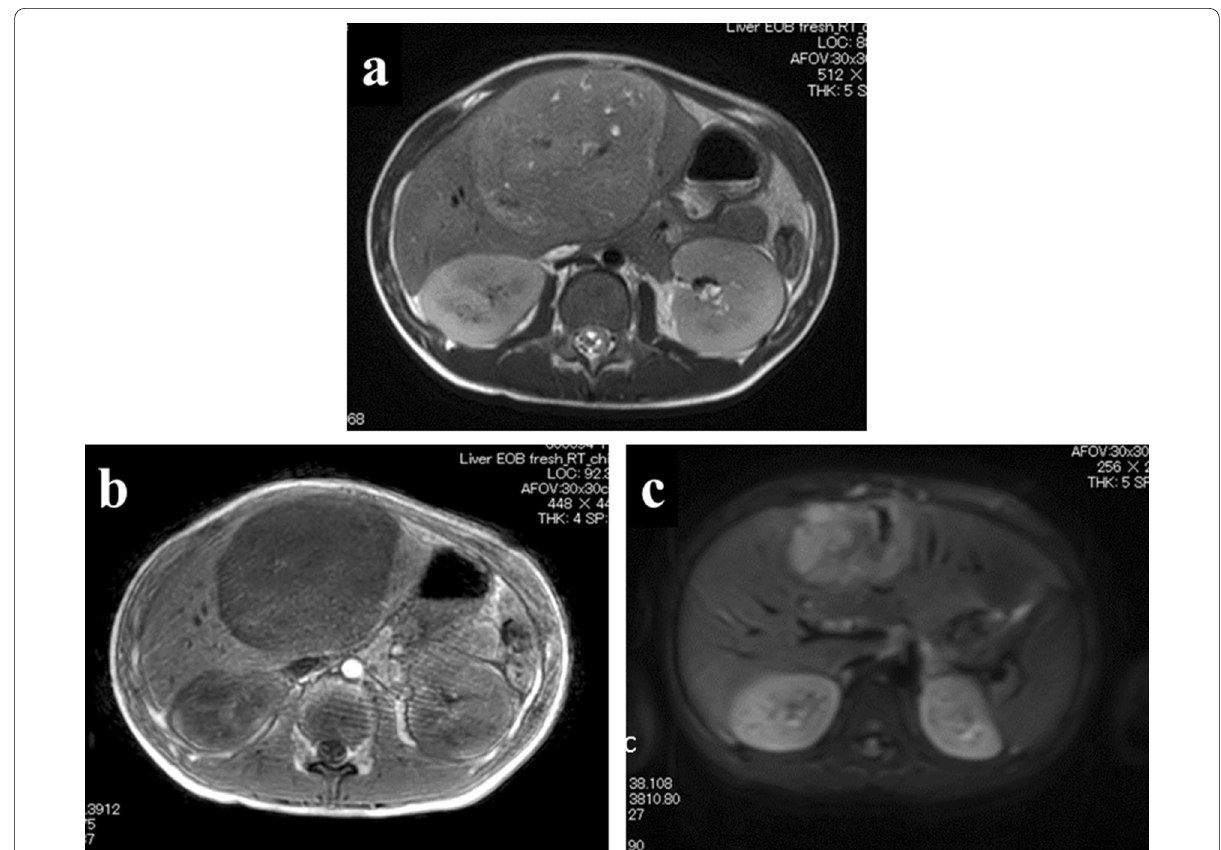
Fig. 2 MRI findings. The tumor shows low intensity on T1-weighted imaging ( a ) and high intensity on T2-weighted imaging ( b ) with partial diffusion restriction ( c )